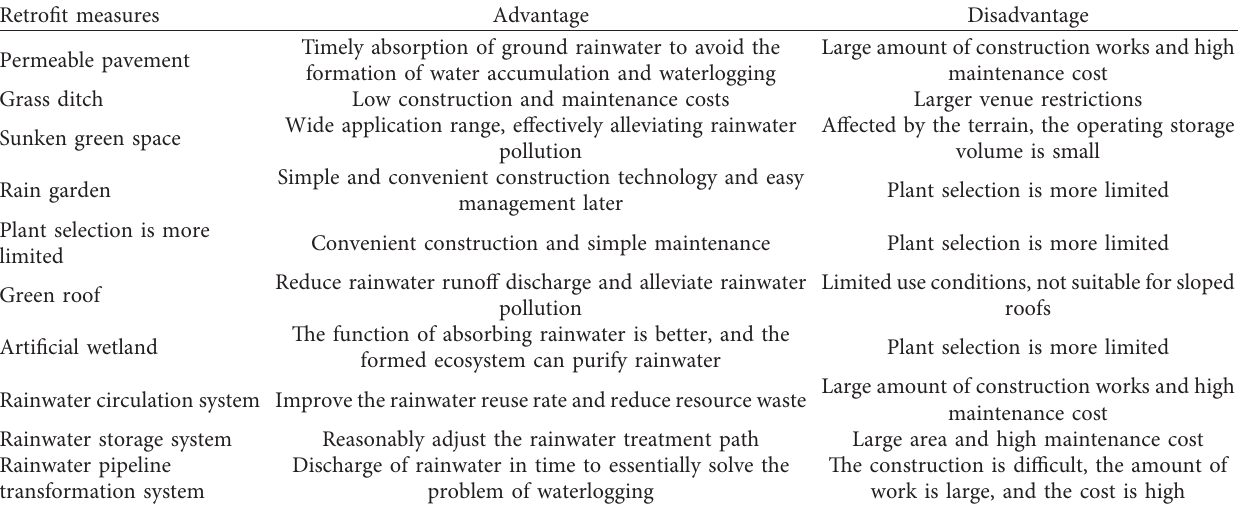
Table 2: Comparison of the advantages and disadvantages of various sponge transformation measures.